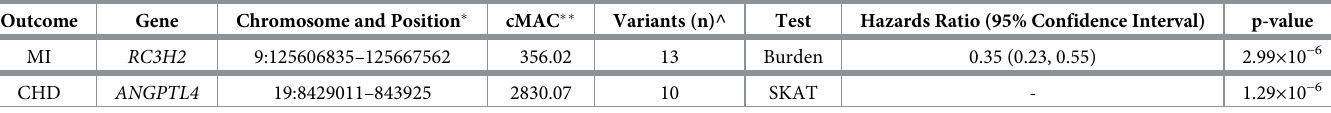
Table 3. Genes associated with incident MI and CHD in gene-based